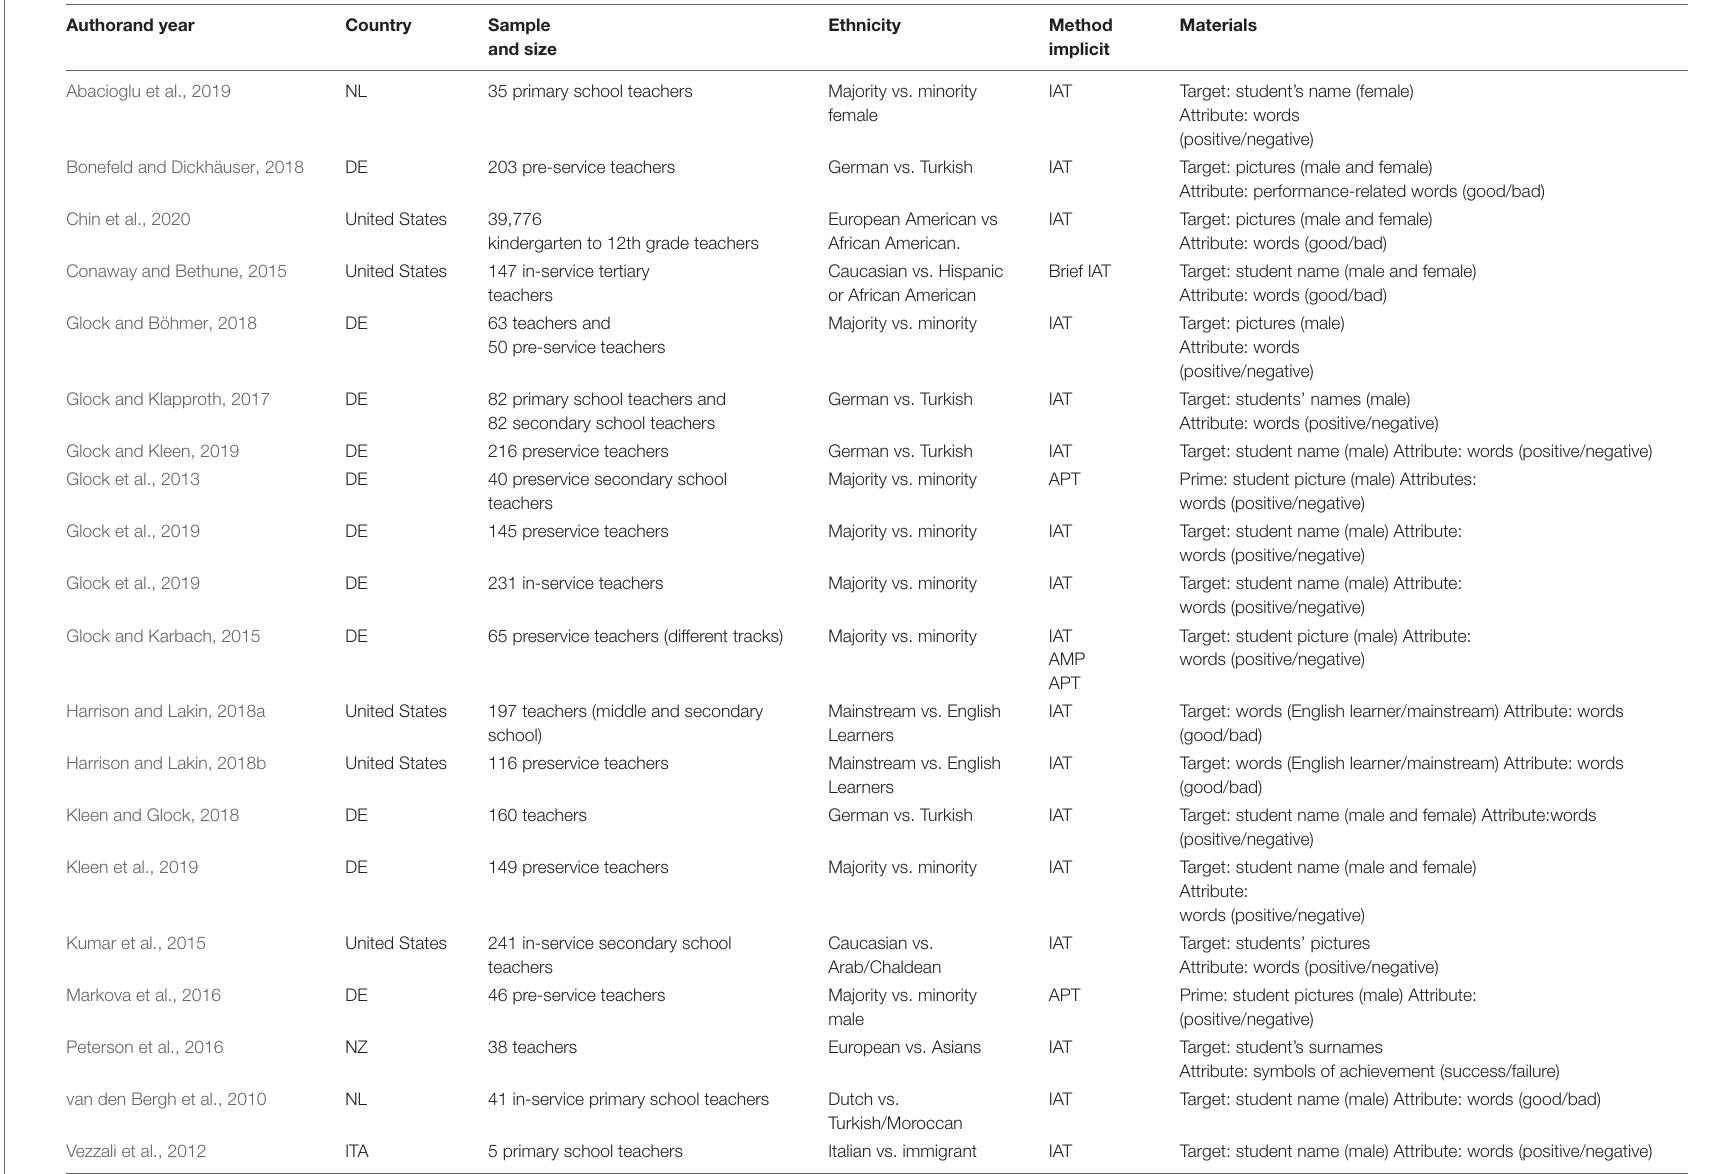
TABLE 1 | Information extracted from the selected